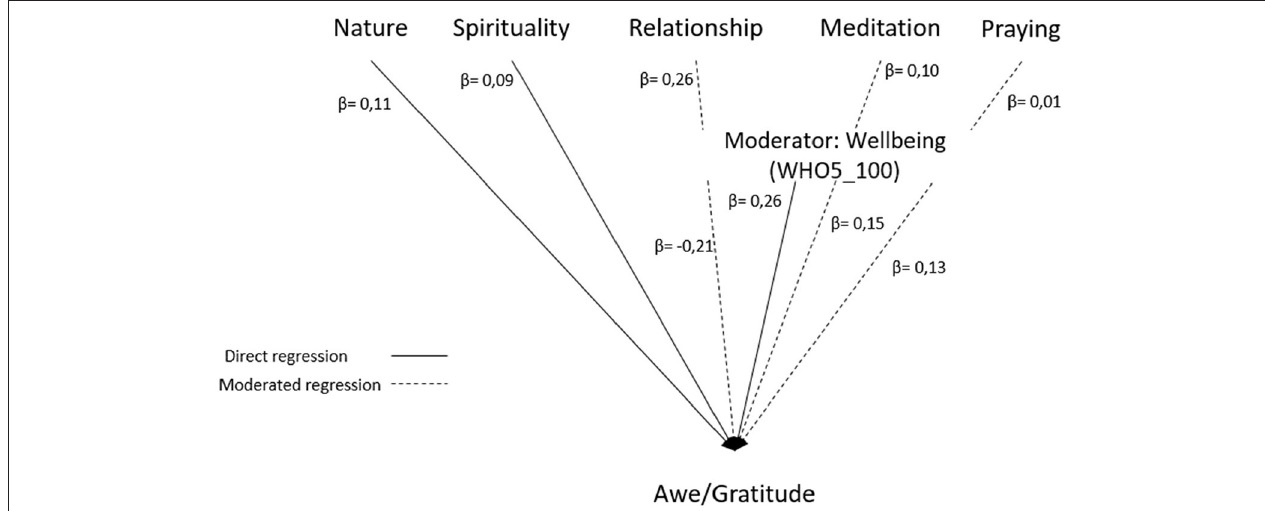
FIGURE 2 | Moderator model for Awe/Gratitude (GrAw), R 2 = 0.36, with well-being (WHO-5) negatively moderating the regression effect of Relationship, but positively moderating the effect of Meditation and Praying on Awe/Gratitude.